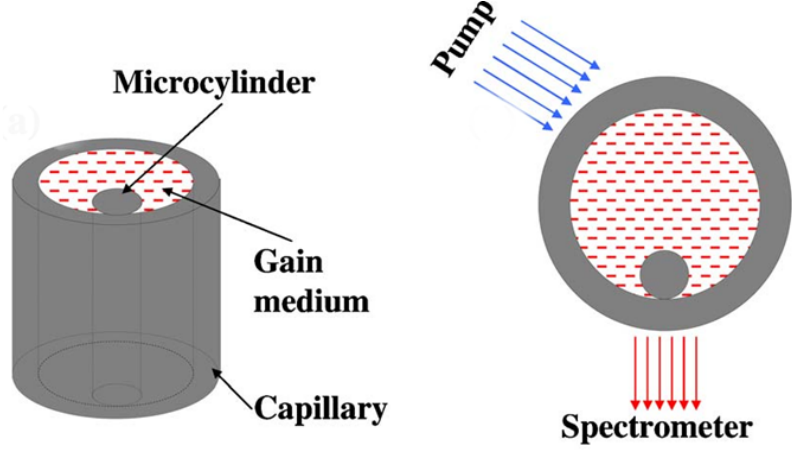
Figure 6. Side view and section view of communication fiber dye laser [55,56].